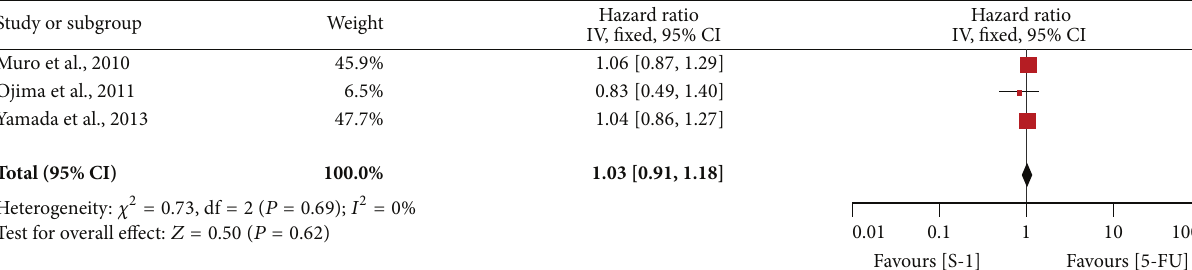
Figure 6: Forest plot of hazard ratio of progression-free survival.